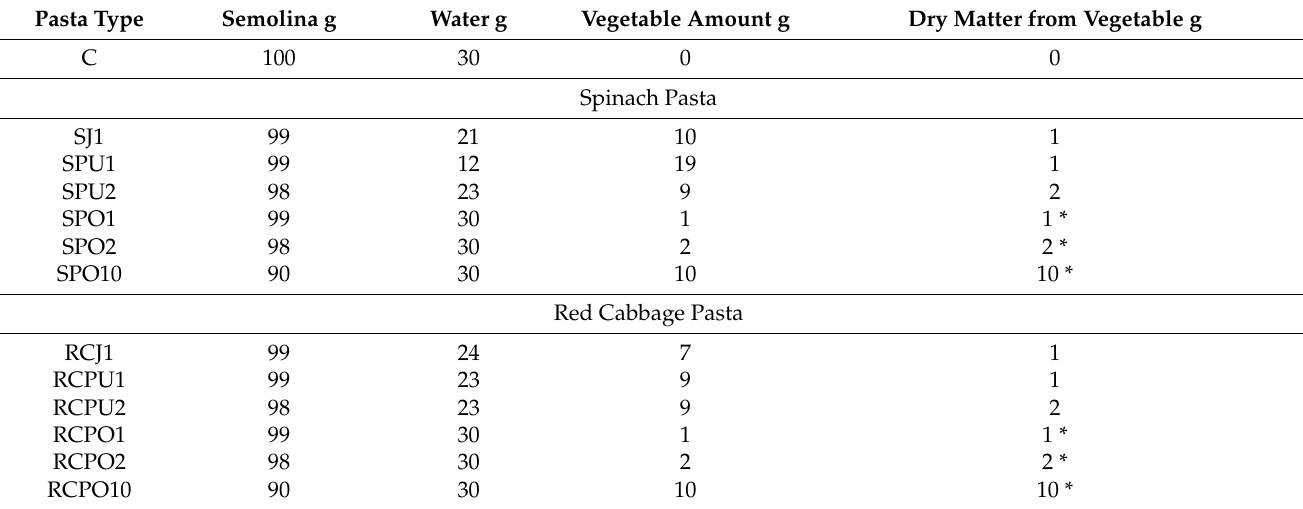
Table 1. Pasta recipes (130 g